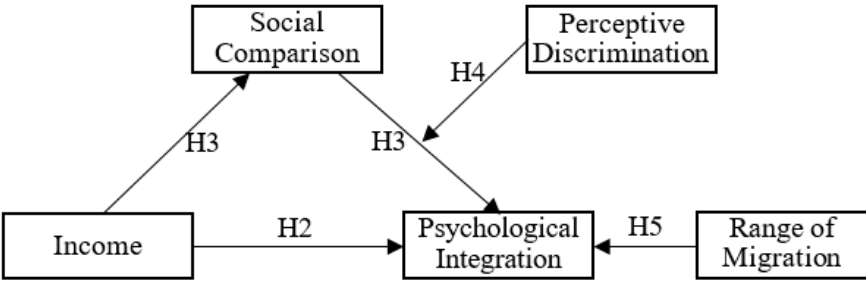
Figure 1. The theoretical hypothesis model of psychological integration paths.